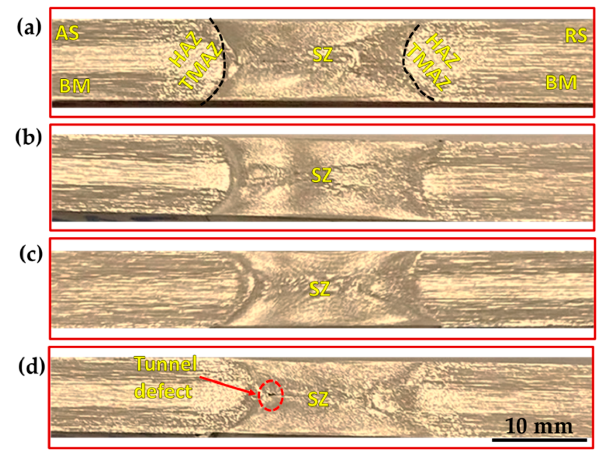
Figure 14. Macrostructure of the AA1050 BT-FSPed specimens at at a constant rotation rate of 600 rpm using Sq pin (where BM: base material, SZ: stir zone, HAZ: heat-affected zone, and TMAZ: thermo-mechanically affected zone) and different travel speeds of ( a ) 50 mm/min; ( b )100 mm/min; ( c ) 200 mm/min, and ( d ) 300 mm/min.